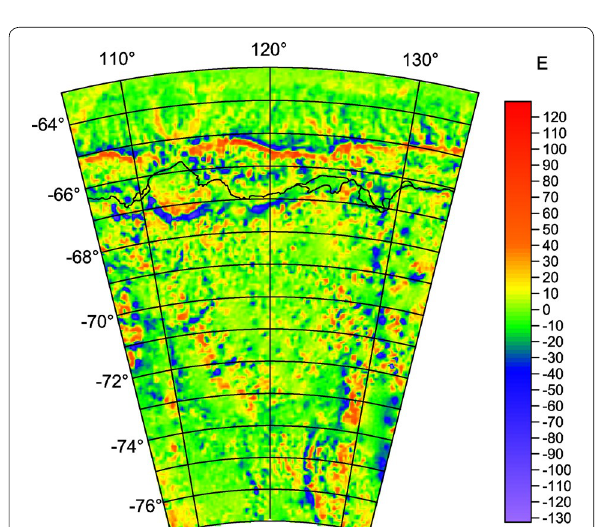
Fig. 11 Δ g (mGal) in the Wilkes Land anomaly basin, computed using the RET 14 model